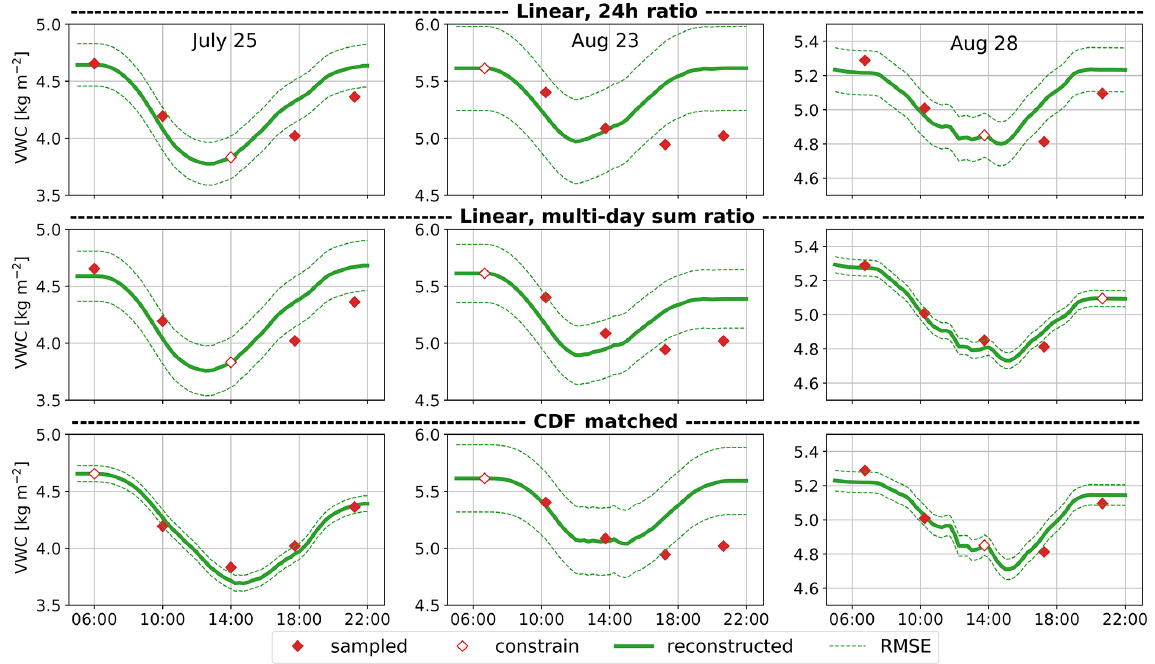
Figure 6. Best diurnal VWC reconstructions for 25 July and 23 and August 28 (2019) for three different methods of estimating transpiration. The upper row shows the results for using the simplest, linear estimate of transpiration. The middle row shows the reconstructions using linear estimates of transpiration but now considering 3, 5, and 7d rather than 24h. The lower row shows the results after CDF matching, considering all data, and 5 and 3d for the CDF matching, respectively. The dashed green lines represent one RMSE above and one RMSE below the reconstructed VWC. The measurement which is used to constrain the reconstructed line is accentuated with an open marker.